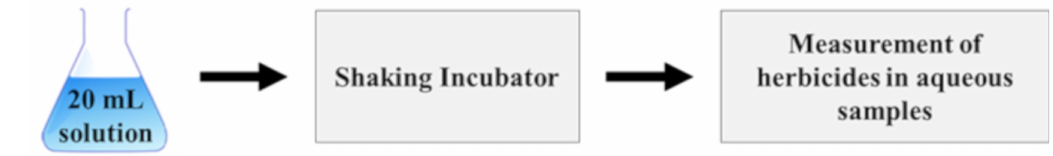
Figure 1. The diagram for batch experiments for adsorption of herbicides in aqueous